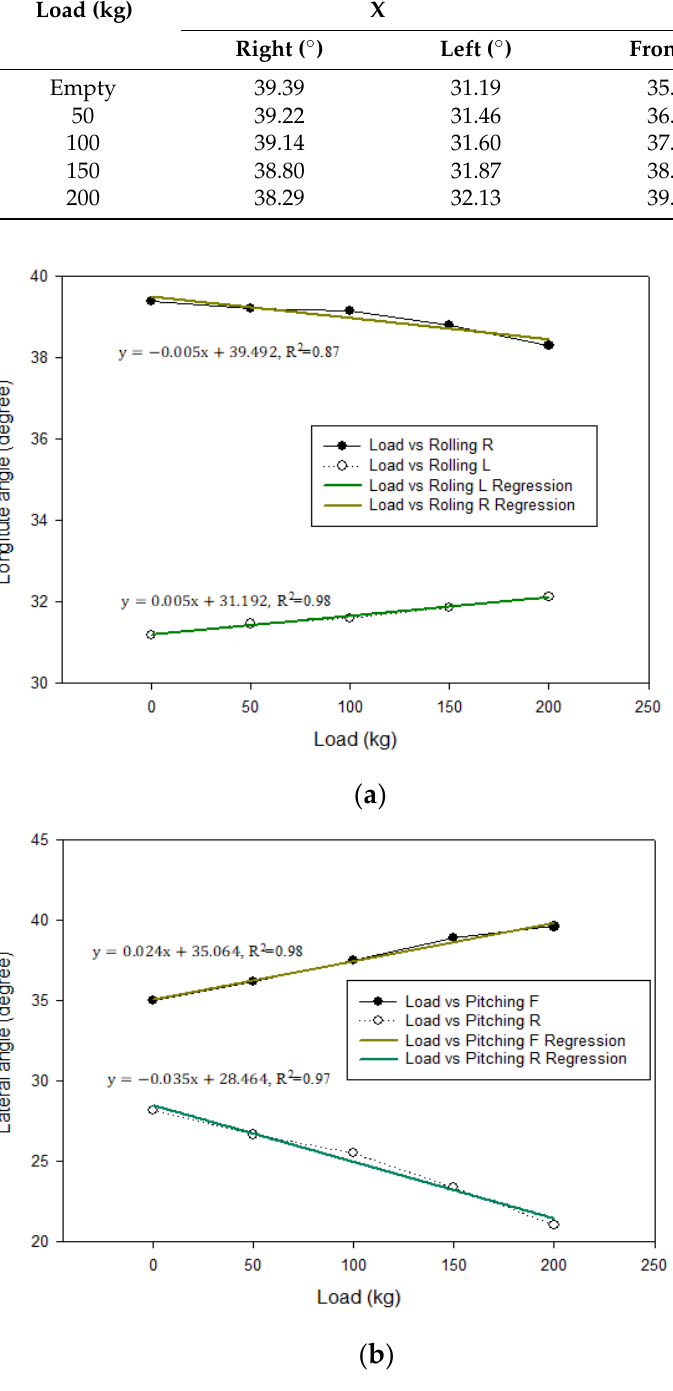
Figure 3. Overturning angle of pepper harvester in each loading condition ( a ) X direction ( b ) Y di- rection.